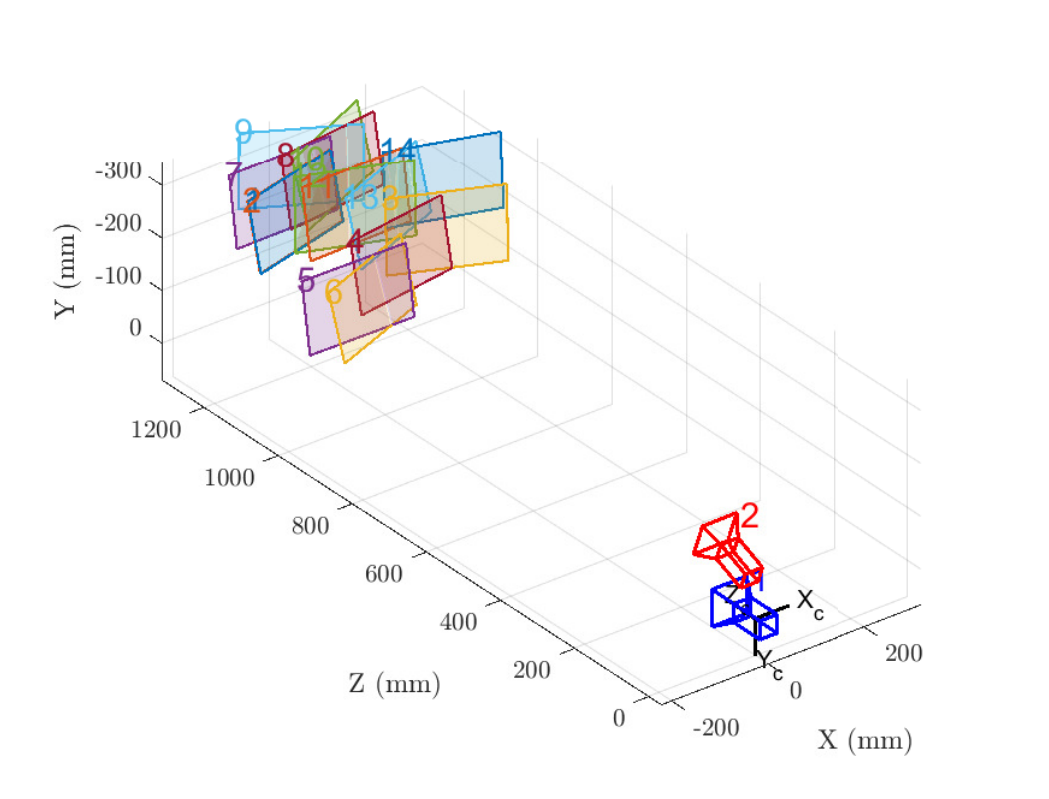
Figure 7. Extrinsic parameters visualization for the cross–calibration of ToF–sensor (blue) and thermal camera (red) using a moving checkerboard pattern, combining ToF reflectivity with thermal RGB